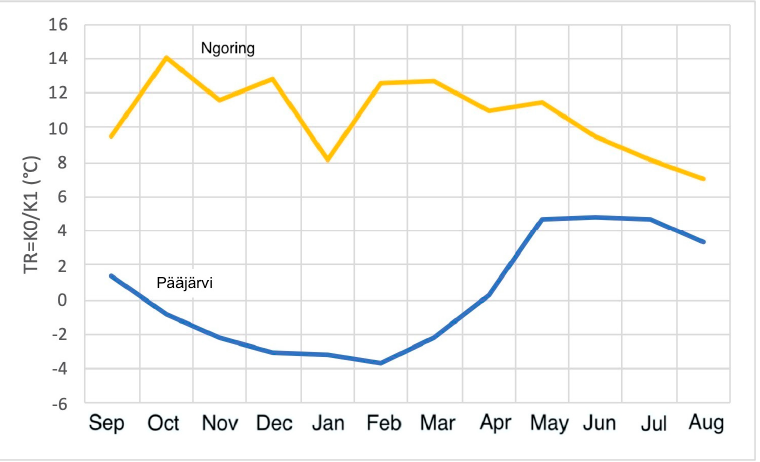
Figure 4. The temperature parameter T R in Lake Pääjärvi and Ngoring Lake. This temperature indicates how much solar radiation compensates for air temperature forcing in the annual cycle of lakes. Data from Figure 2.